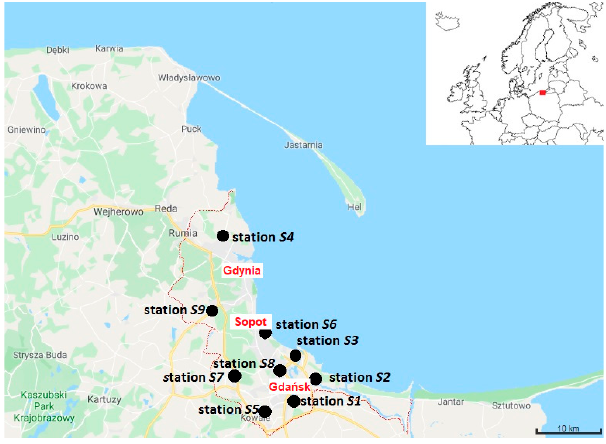
Figure 1. Location of air pollution monitoring stations within the Tri-City agglomeration (the agglomeration consists of Gda ń sk, Gdynia and Sopot, bounded with the red dotted line). Source: Own elaboration.